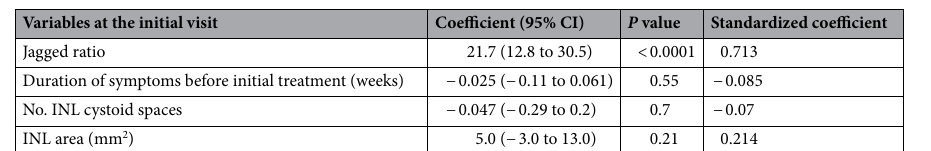
( r = 0.717, P < 0.0001), number of cystoid spaces in the inner nuclear layer (INL) ( r = 0.386, P = 0.018), and INL area ( r = 0.382, P = 0.019) were significantly correlated with the total number of anti-VEGF injections. Figure is created using JMP version 15.2.1 (SAS Institute, Inc., Cary, NC, USA, available at https:// www. jmp. com/ ja_ jp/ home. html).